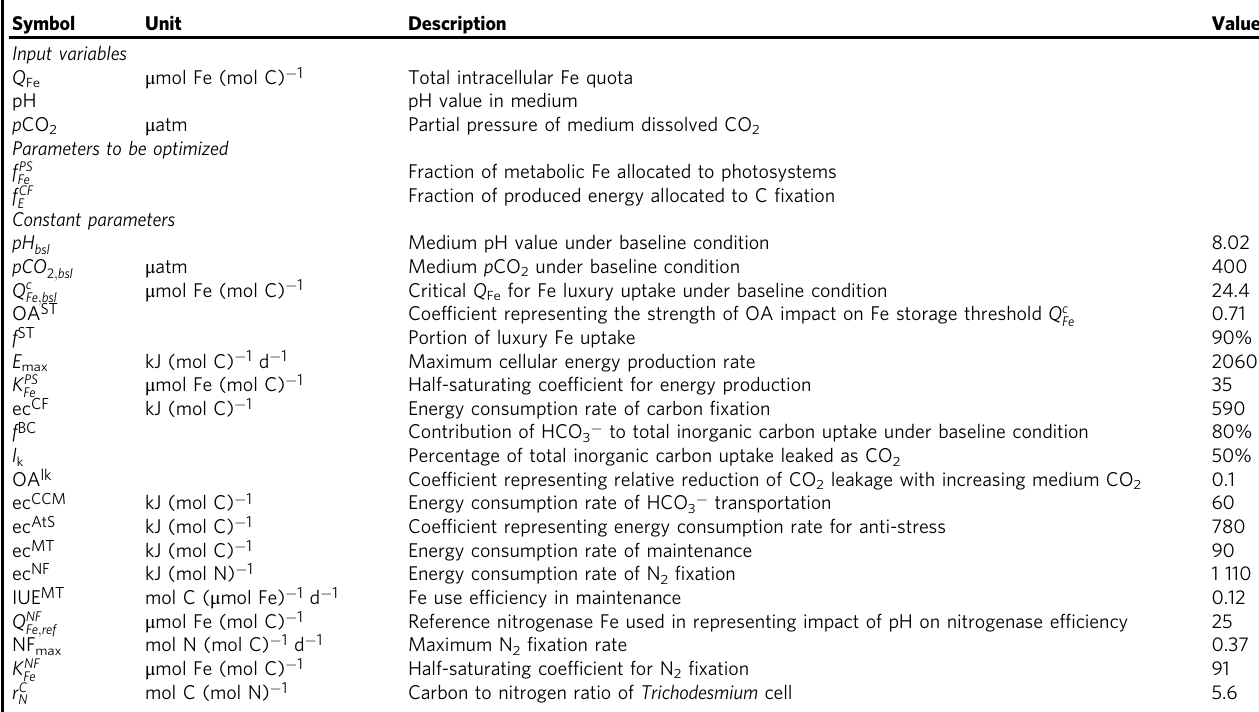
Table 3 Model variables and